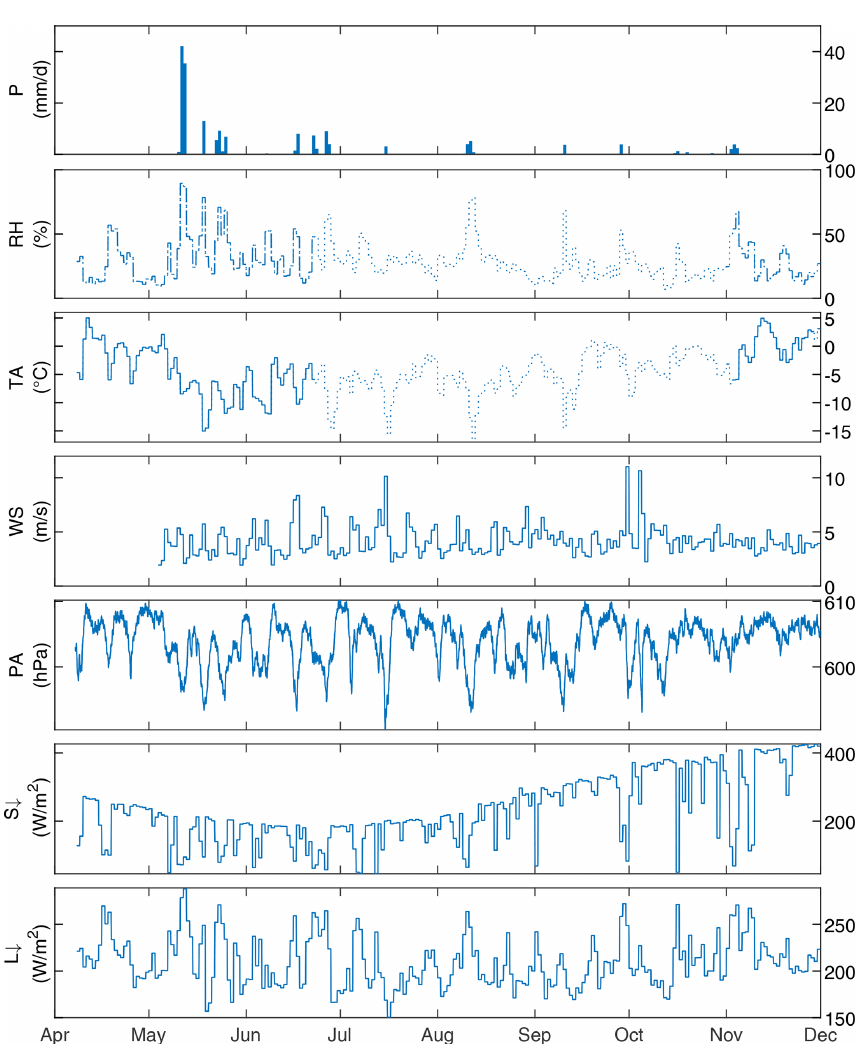
Figure 2. Meteorological observations at Tapado with daily precipitation ( P ), average daily relative humidity (RH), air temperature (TA), wind speed (WS), air pressure (PA), incoming shortwave radiation ( S ↓ ), and incoming longwave radiation ( L ↓ ) from April to Decem- ber 2017. Dotted lines indicate the TA and RH